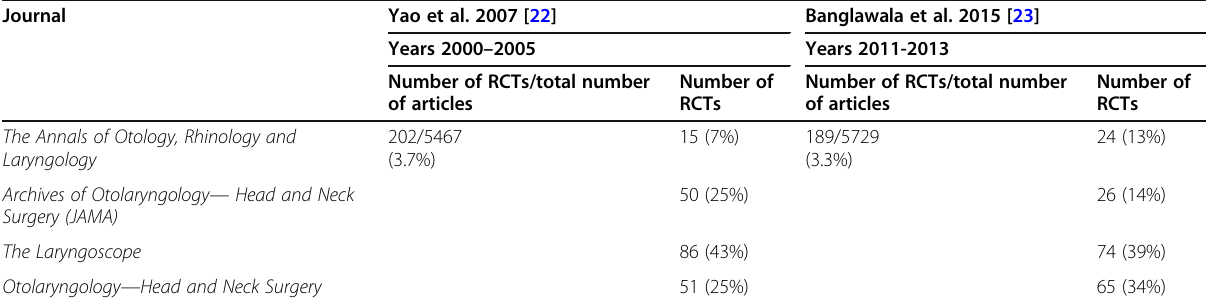
Table 1 Prevalence of RCTs in the field of otolaryngology in the last 2